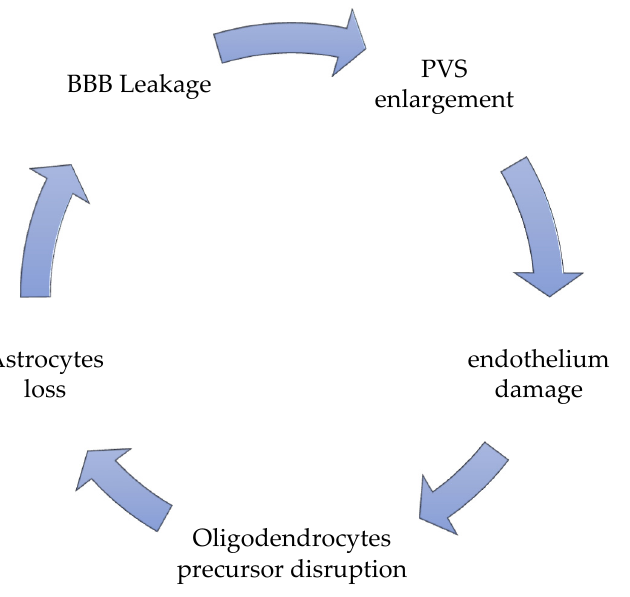
Figure 1. The vicious circle of SVD pathology.